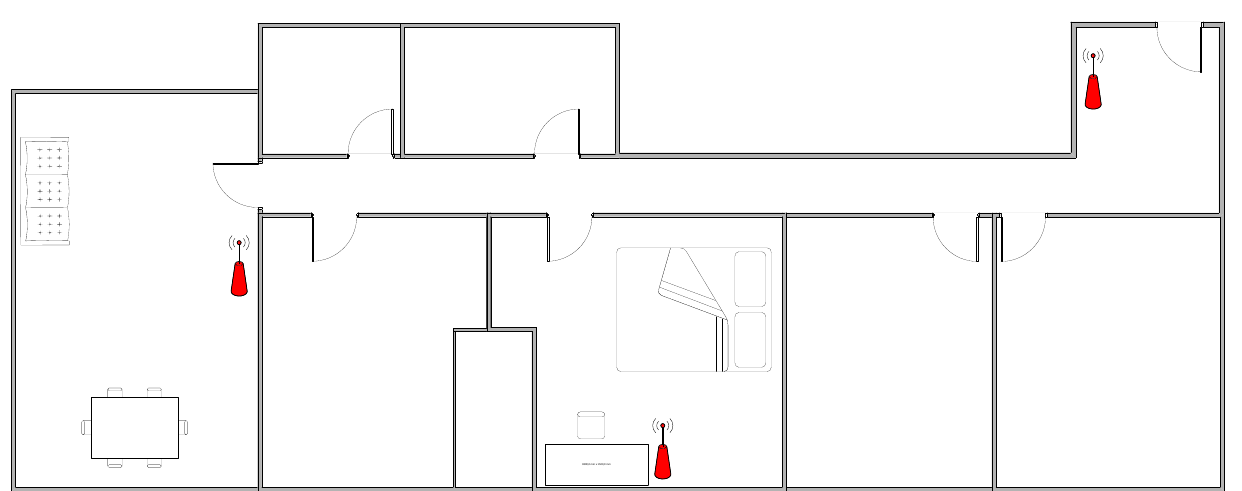
Figure 2. Distribution of the Access point in the